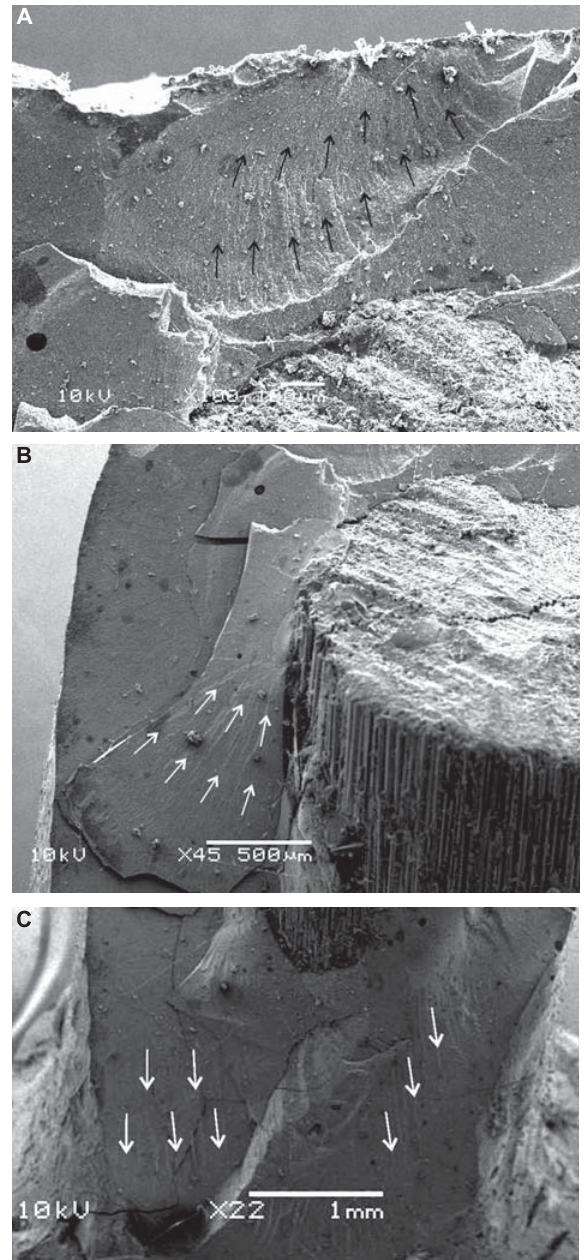
Figure 5- Scanning electron microscopy image of control group. There is displacement of the buccal surface of the (cid:25)(cid:20)(cid:13)(cid:5)$(cid:9)(cid:5)(cid:31)(cid:19)(cid:20)(cid:6)(cid:7)(cid:17)!(cid:9)(cid:15)(cid:4)(cid:5)(cid:9)(cid:19)(cid:20)(cid:6)(cid:15)"(cid:9)&(cid:4)(cid:5)(cid:9)(cid:18)(cid:14)(cid:5)(cid:13)(cid:9)(cid:19)(cid:20)(cid:6)(cid:15)(cid:9)(cid:6)(cid:12)(cid:10)(cid:10)(cid:5)(cid:13)(cid:6)(cid:9)(cid:2)(cid:9)(cid:25)(cid:13)(cid:2)(cid:25)’(cid:9) in the mesiodistal direction, which is a consequence of shear stress above the post. (A) Minimal thickness area and hackle lines (black arrows) indicating the start of the fracture. (B) Hackle lines (white arrows) initiating at the composite/post interface. (C) Hackle lines (white arrows) indicated in the buccal surface showing the fracture